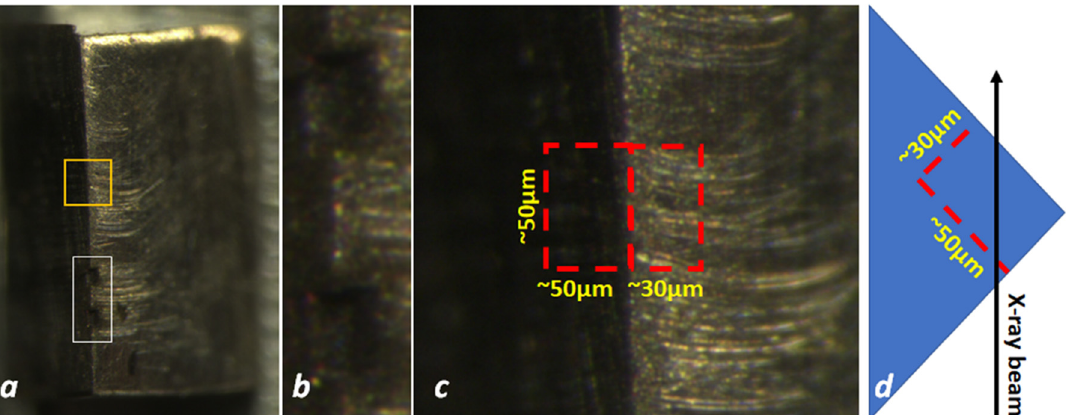
Figure 1. ( a ) Bulk sample of 50Cu–50Fe. ( b ) Cavities formed as a result of samples being cut by the laser cutting machine (white box in ( a )) for high pressure measurements. ( c ) Laue diffraction scan area (yellow box in ( a )) as projected onto horizontal and vertical planes in ( d ). Red dotted lines denote projections of edges of a DAC-sized sample that could be cut by the laser system from the scan